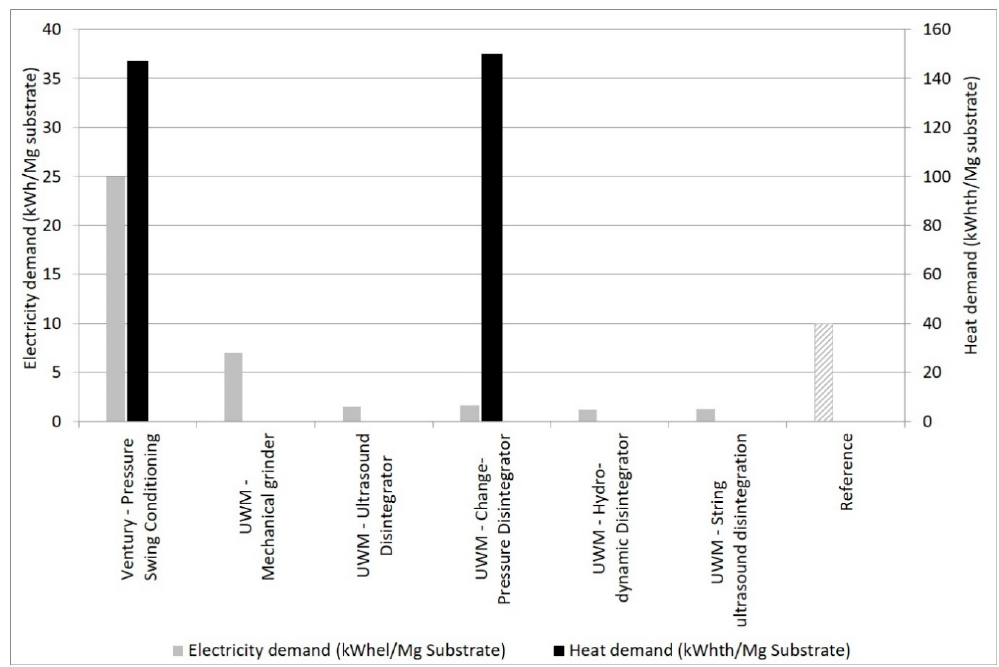
Figure 1. Electricity and heat demand for pre-treatment technologies (technology of “Hyperthermics AS” not included as no data for energy demand was available).